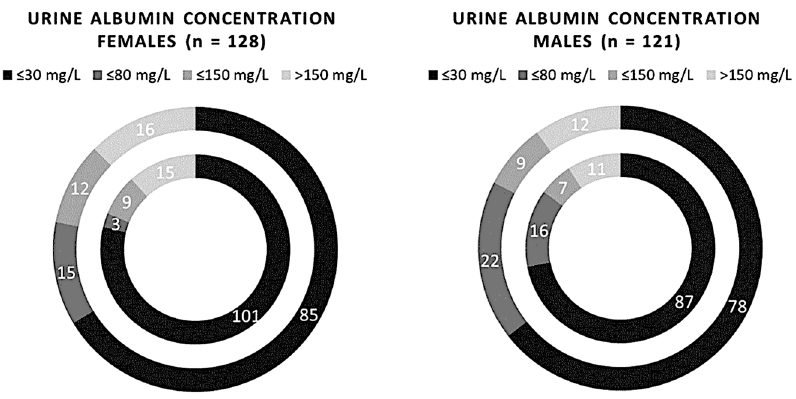
Figure 4. Comparison of 249 samples of albuminuria measured using the semi-quantitative and quantitative methods, redistributed on sex. The inner circle represents the Cobas C 501 assay results, and the outer circle indicates the results of the Sysmex UC 3500.